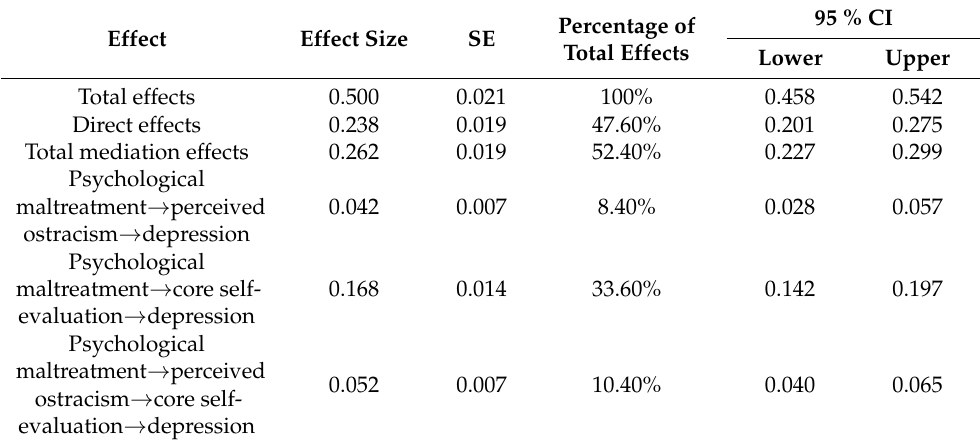
Table 3. Bootstrap analysis of multiple mediation